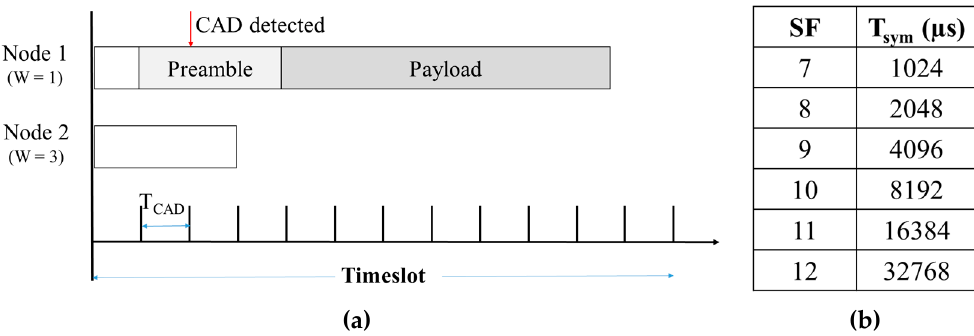
Figure 7. The collision avoidance mechanism. ( a ) Contention avoidance mechanism example with two nodes; ( b ) Symbol time (Tsym).